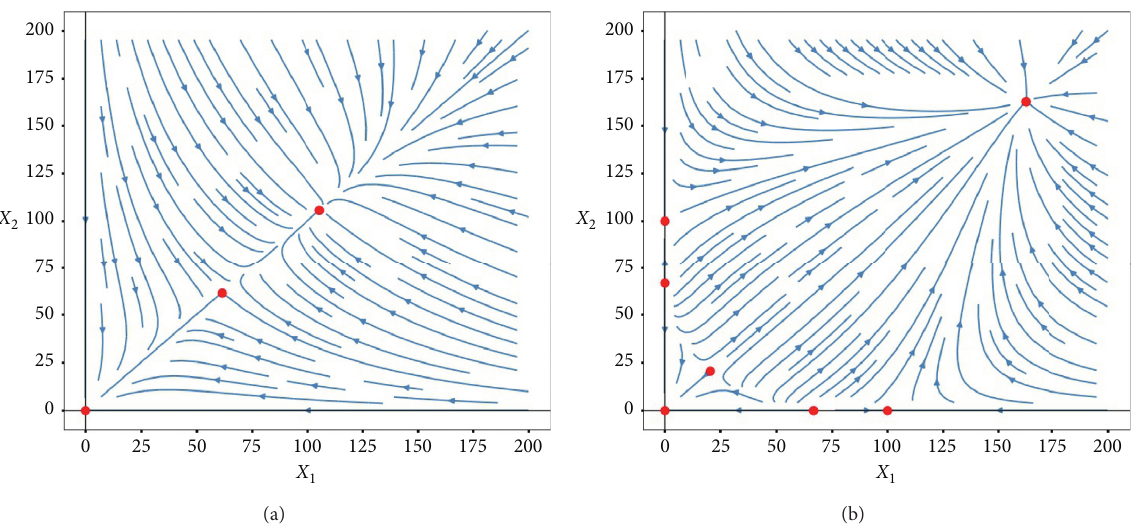
Figure 8: Obligate-obligate mutualism with cooperation in two populations: (a) we have the case where b that intraspecific cooperation is lower than mutualism; (b) we have b mutualism weight the same. Here, r